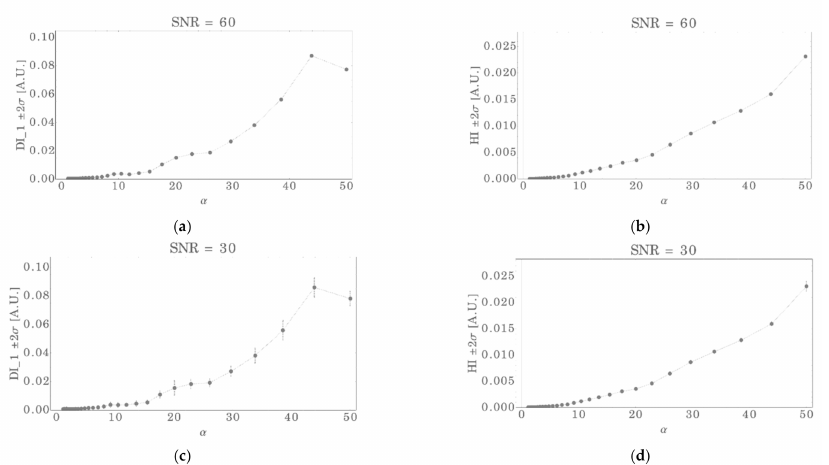
Figure 4. Mean value and standard deviation ( ± 2 σ ) of the estimators depending on the amount of damage α . ( a ) Damage indicator DI 1 @ SNR = 60 dB; ( b ) The proposed damage indicator HI @ SNR = 60 dB; ( c ) damage indicator DI 1 @ SNR = 30 dB; ( d ) The proposed damage indicator HI @ SNR = 30